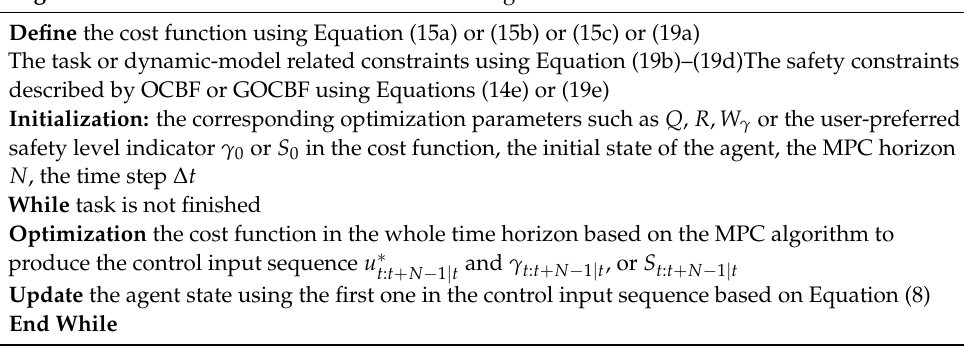
Algorithm 1: The MPC-OCBF or MPC-GOCBF